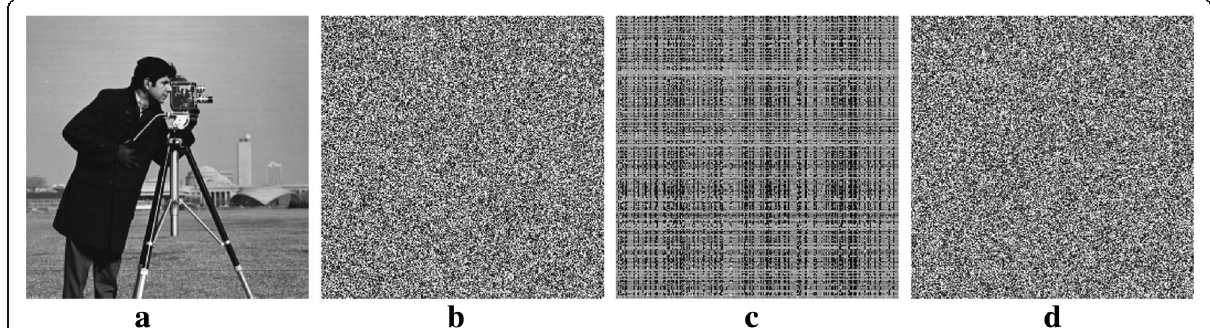
Fig. 3 a Plain image (cameraman). b Directly CA-encrypted image (cameraman). c Scrambled image (cameraman). d The cipher image after scrambling the plain image